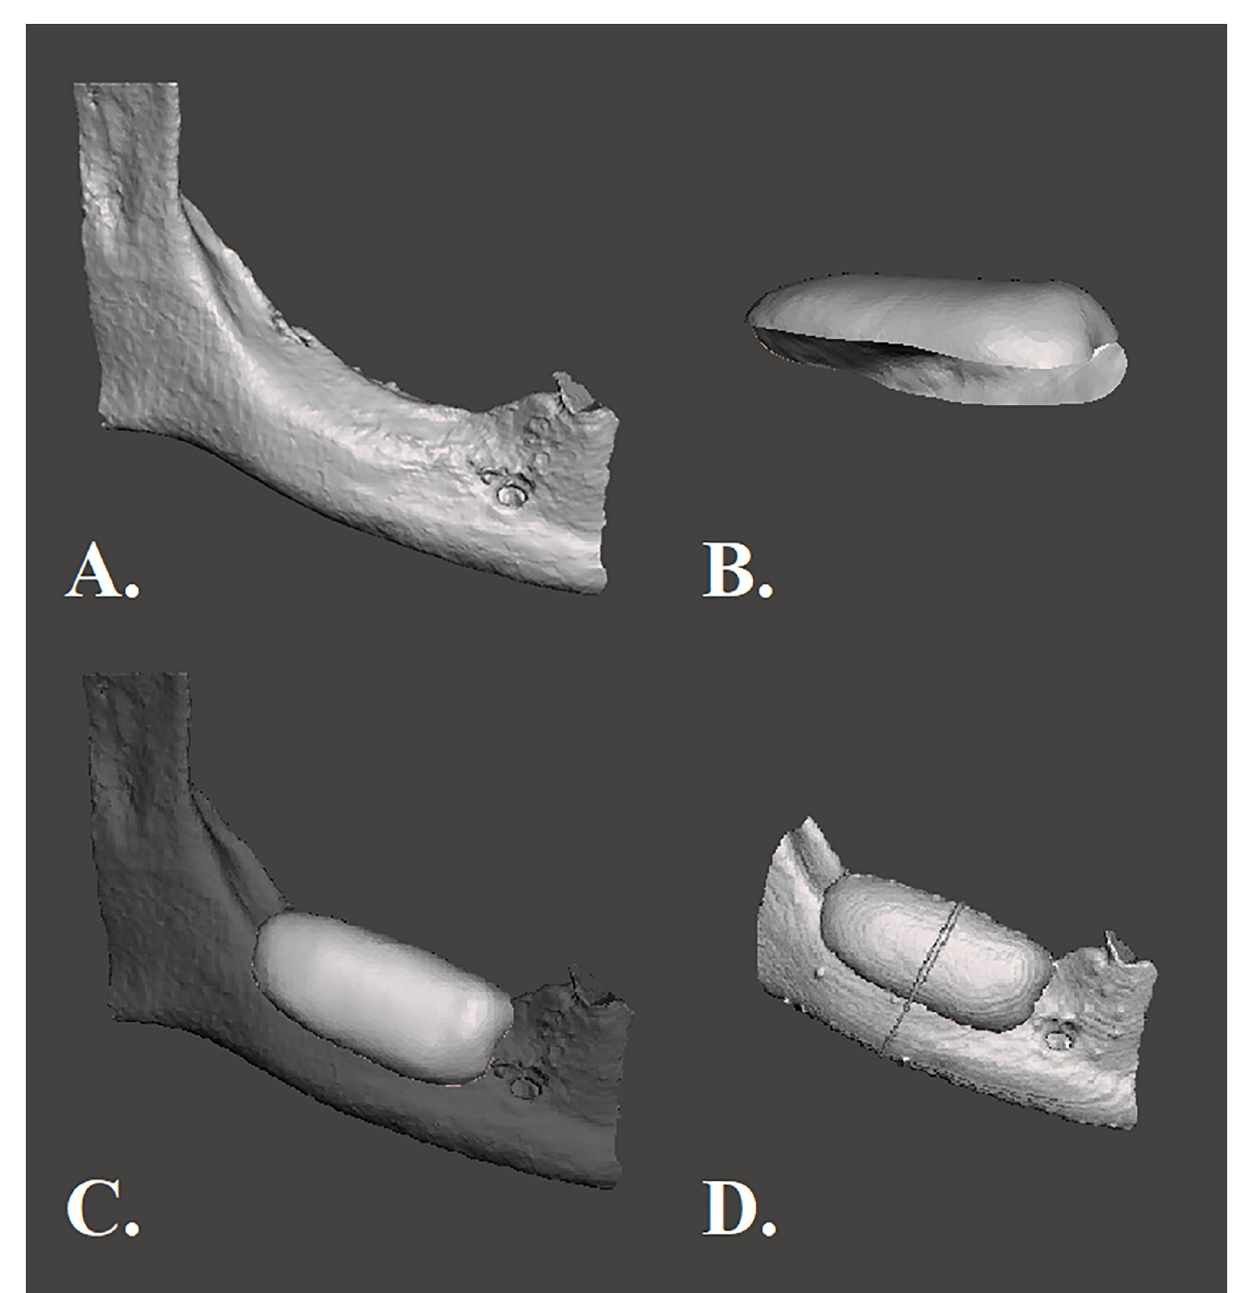
Fig 3. Representative 3D models of an atrophic mandible combined with one out of three large grafts. (A) Frontal view of a CAD mandibular model. (B) Lateroinferior view of a CAD large mandibular graft. (C) Frontal view of the graft fitted on the recipient site of the mandible. (D) Frontal CBCT view of the fitted